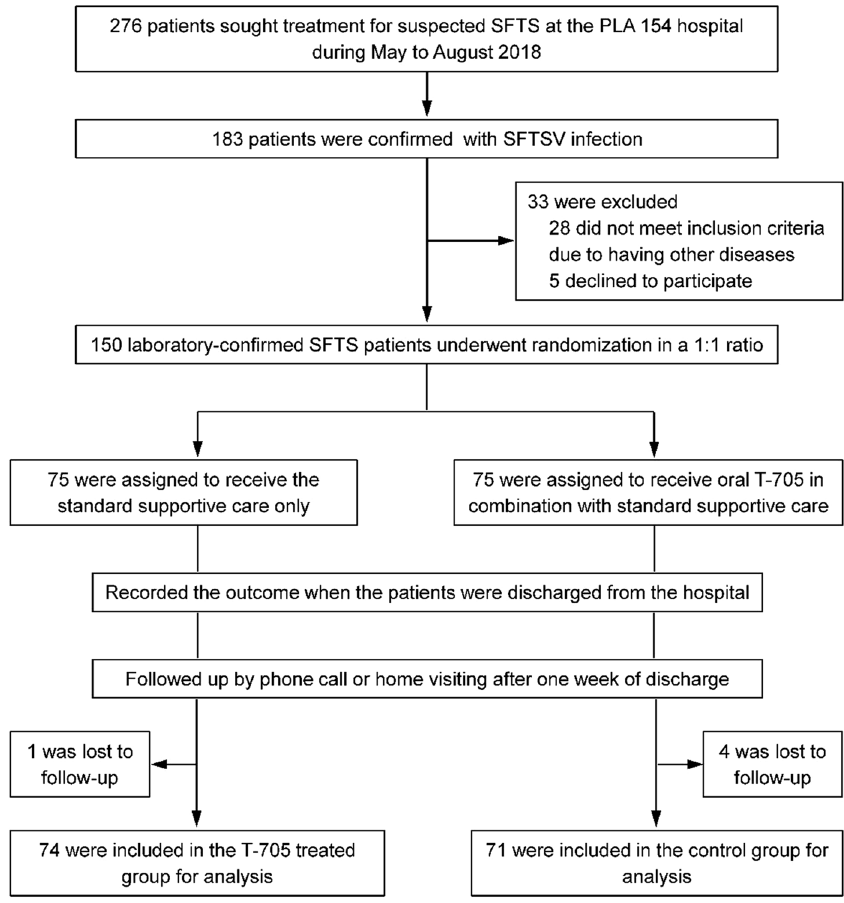
T-705-treated patients and 11 controlled patients (Fig. 8), with a mean (±SD) sequencing depth of 3090 (±840) fold genome coverage obtained. Before treatment, the rates of total, transition, and transversion mutations were comparable between the two groups (All P > 0.05; Supplementary Table S3). During the fi rst week of treatment, all the mutation rates were signi fi cantly increased in the T-705 treated group in comparison with the control group, with P values of 0.035, 0.041, and 0.019 for total, transition, and transversion mutations respectively (Fig. 8a – c), while the ratio of transitions/transversions did not show a signi fi cant difference between the two groups ( P > 0.05, GEE model; Supplementary Fig. S13). The most pronounced difference (de fi ned as a change of mutation rate from baseline) was observed at day 4 (Table 2). Increased virus mutations were obviously seen in the survival patients but not seen in the fatal patients after the treatment with T-705 (Fig. 8e – g), while no increase of virus mutations was observed in survival or fatal patients without receiving T-705 treatment (Fig. 8i – k). The dynamic trend of accumulating mutations displayed a consistent pattern with that of the CT values of SFTSV in the T-705 treated group (Supplementary Fig. S14), suggesting that T-705 reduces the viral loads likely through inducing both transition and transversion mutations that are detrimental to viral proliferation. As seen in the mouse model, no predominant pattern of transition mutations or transversion mutations was observed in serum samples collected from SFTS patients (Supplementary Fig.